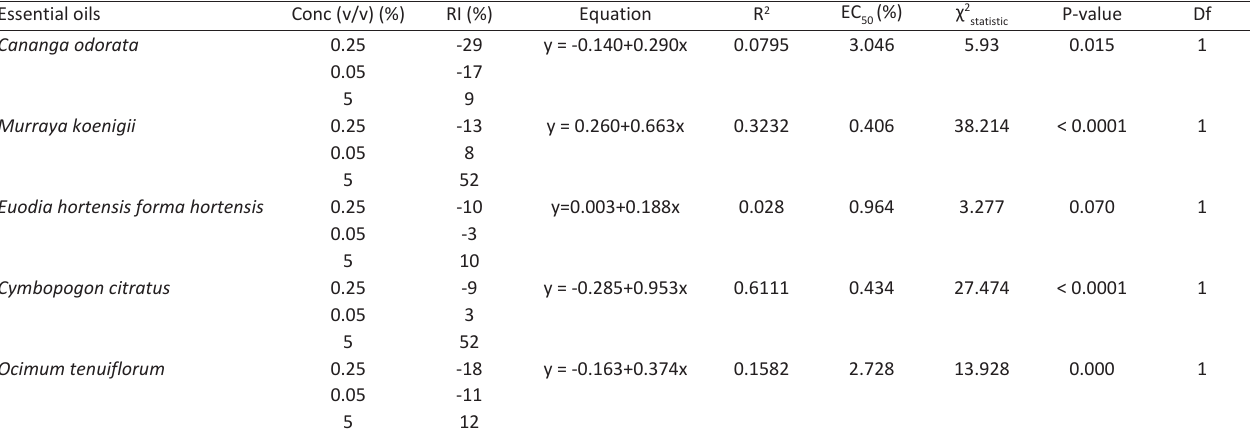
Table 4 - Summary of repellent effect (6-8 hours) on the adult whiteflies at different concentrations (Using Probit analysis)